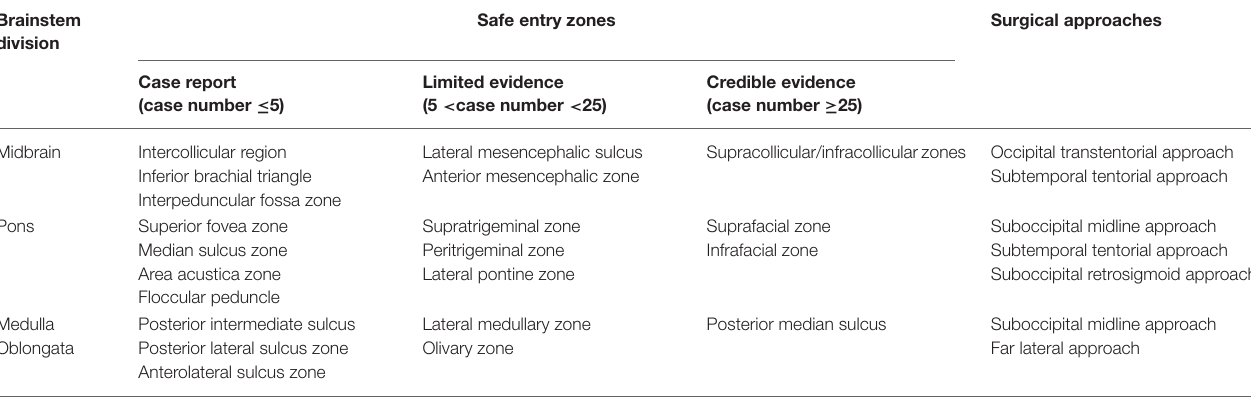
TABLE 3 | Safe entry zones into the brainstem and common surgical approaches (68, 76).